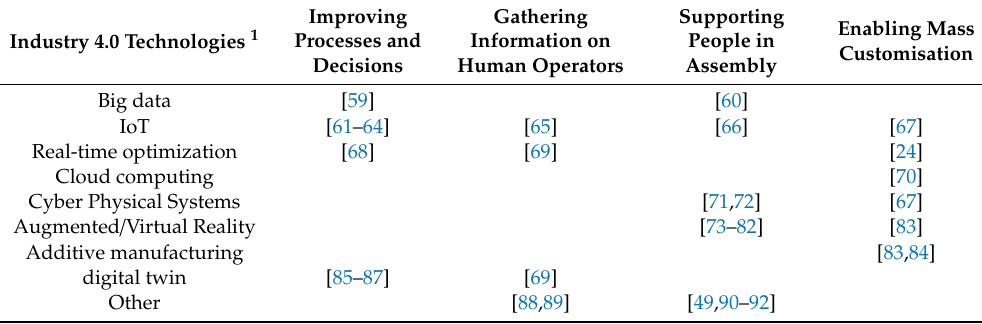
Table 3. Technologies of Industry 4.0 by